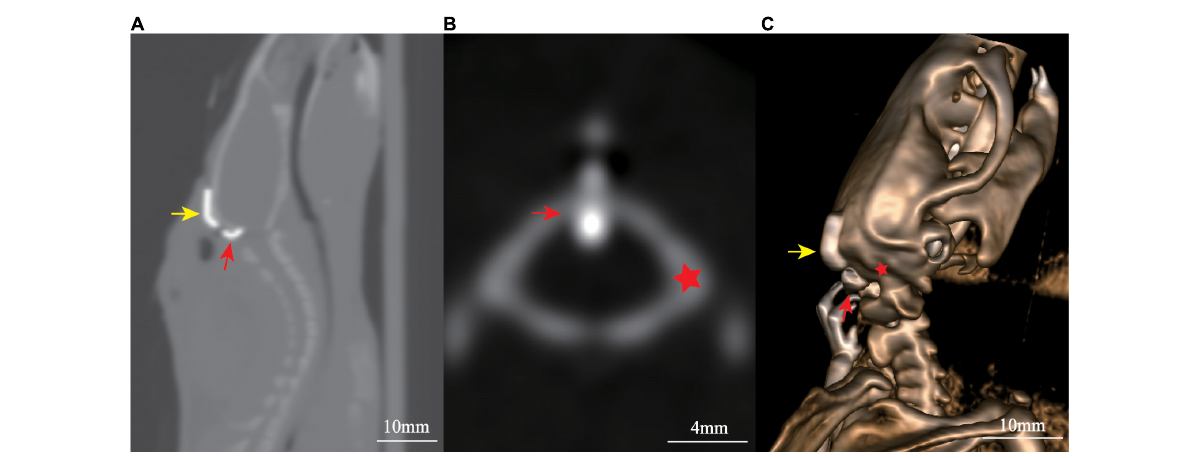
adapted to rats of different sizes. Moreover, the cannulation